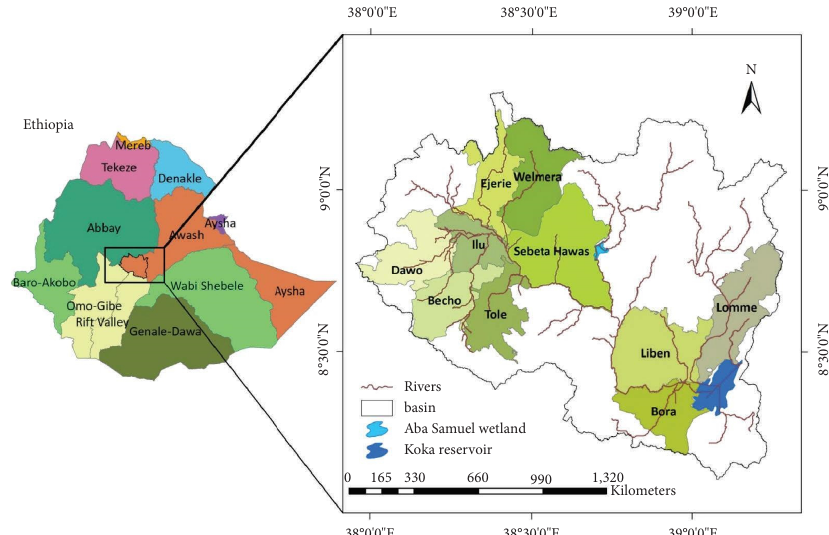
Figure 1: Location map and food afected districts of the